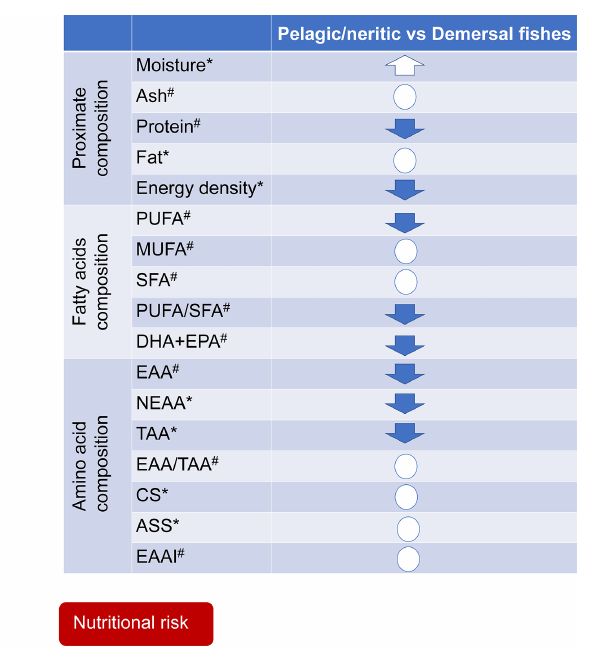
FIGURE 7 Summary of the dietary switch in the Zhuhai population of Indo-Paci fi c humpback dolphins and the potential nutritional risk. The arrows in the table indicate signi fi cantly higher (up-arrows) or lower (down-arrows) nutrition component in pelagic/neritic fi shes compared with demersal fi shes ( p <0.05), while the circles indicate there is no signi fi cant difference. *: Duncan ’ s Multiple-Range Test of ANOVA; #: Kruskal-Wallis test. PUFA, Polyunsaturated fatty acids; MUFA, Monounsaturated fatty acids; SFA, Saturated fatty acids; DHA, Docosahexaenoic acid; EPA, Eicosapentaenoic acid; EAA, Essential amino acid; NEAA, Non-essential amino acids; TAA, Tatol amino acid; CS, Chemical score; ASS, Amino acid score; EAAI, Essential amino acid